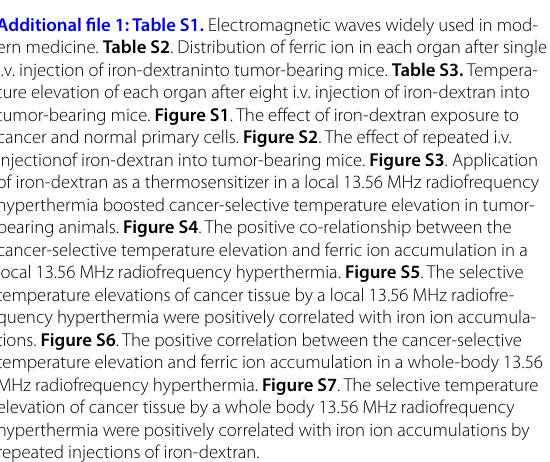
tions. Figure S6 . The positive correlation between the cancer‑selective temperature elevation and ferric ion accumulation in a whole‑body 13.56 MHz radiofrequency hyperthermia. Figure S7 . The selective temperature elevation of cancer tissue by a whole body 13.56 MHz radiofrequency hyperthermia were positively correlated with iron ion accumulations by repeated injections of